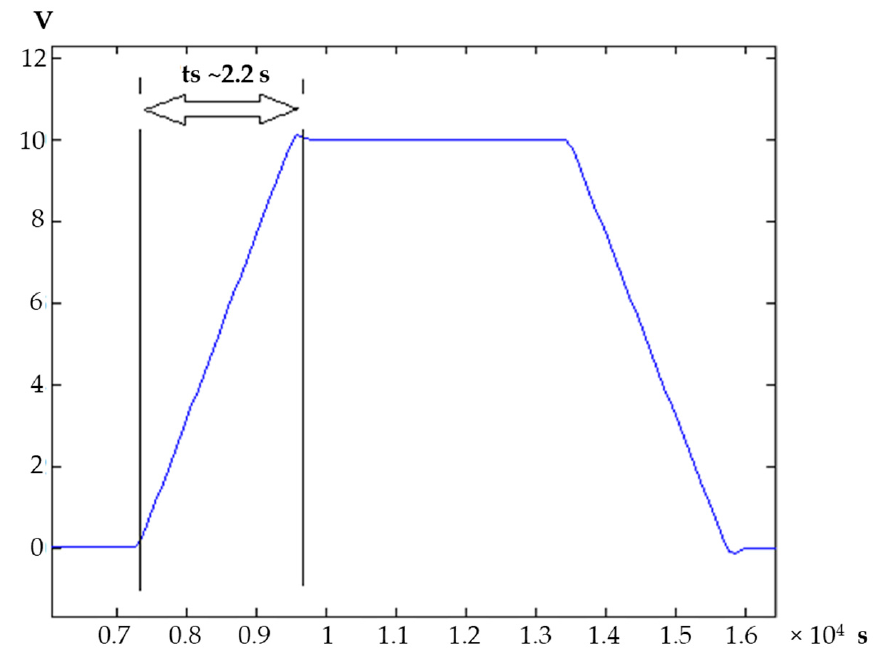
Figure 8. Single-step motor real measurements.